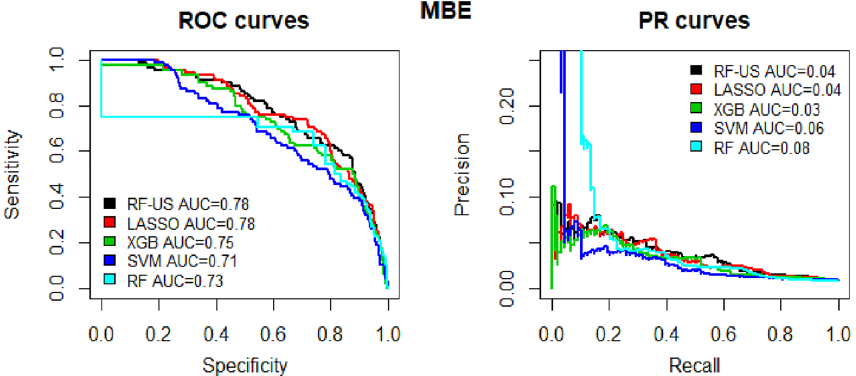
Figure 6. ROC curves for the various models that were assessed for MBE.